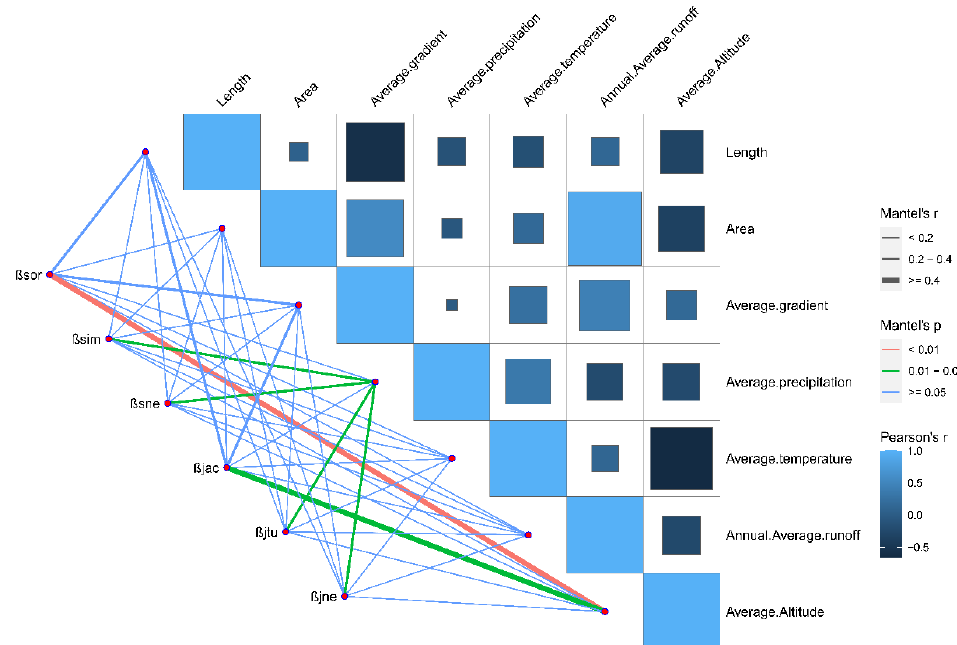
Figure 7. Effects of geographical drivers on the pairwise compositional similarity and the partitioned